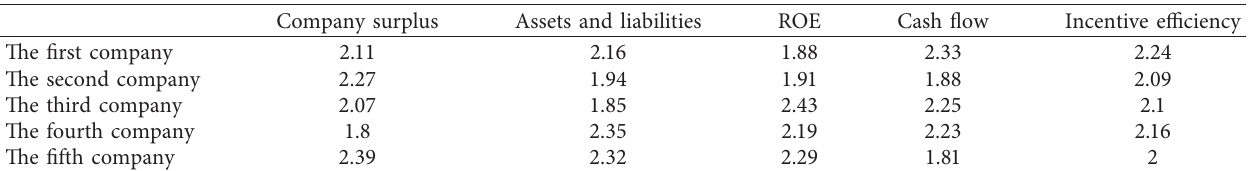
Table 6: Increase rate.